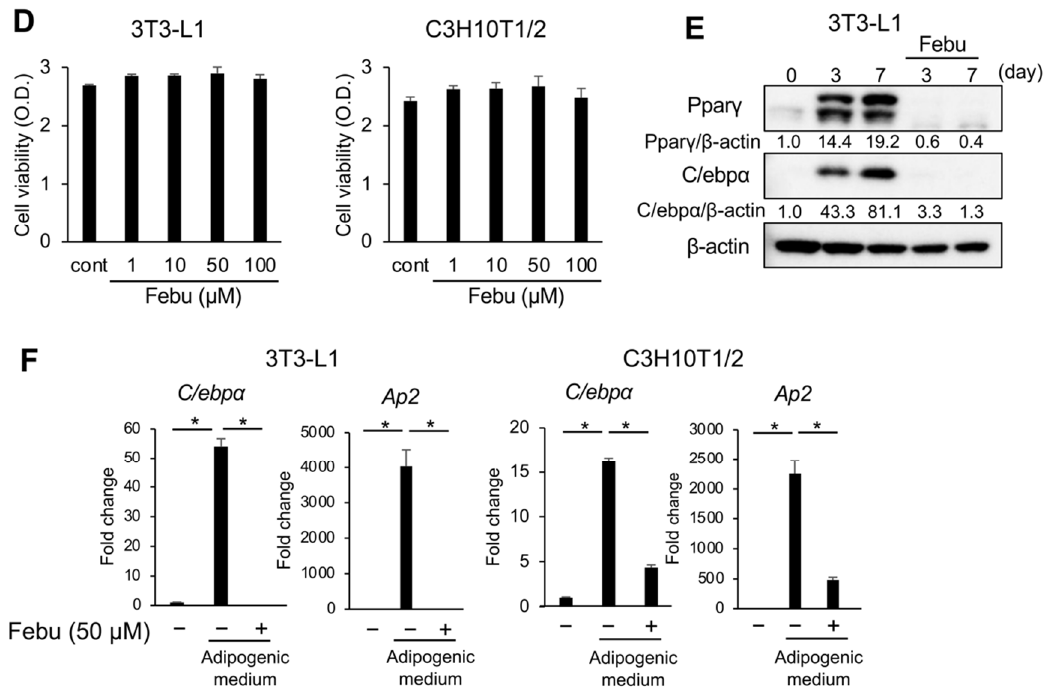
Figure 3. Febuxostat inhibits adipocyte differentiation. ( A ) C3H10T1/2 cells were cultured in adipocyte differentiation medium for seven days. Febu was added at the indicated concentrations. Representative image of Oil Red O staining. Original magnification, × 200. Bar, 100 µ m. ( B ) 3T3-L1 and C3H10T1/2 cells were cultured in adipocyte differentiation medium with or without Febu for seven days. Representative image of Oil Red O staining. Original magnification, × 200. Bar, 100 µ m. ( C ) Oil Red O-positive cells were counted. Data are expressed as the mean ± SD ( n = 4). * p < 0.05. ( D ) 3T3-L1 and C3H10T1/2 cells were seeded in culture dishes, and Febu was added at the indicated concentrations. Cell viability was measured using the 2-(2-methoxy-4-nitrophenyl)-3-(4-nitrophenyl)-5-(2,4-disulphophenyl)-2 H -tetrazolium monosodium salt (WST-8) assay. Data are expressed as the mean ± SD. ( E ) Expression of adipogenic differentiation markers in 3T3 ‐ L1 cells in the presence or absence of Febu analyzed by western blotting. β‐ actin served as the loading control. Relative changes in the band intensities normalized by respective loading controls are indicated. ( F ) mRNA expression of adipogenic differentiation markers in 3T3 ‐ L1 and C3H10T1/2 cells in the presence or absence of Febu using real ‐ time PCR. Gapdh served as an endogenous control to normalize each sample. Data are expressed as the mean ± SD ( n = 3). * p < 0.05.